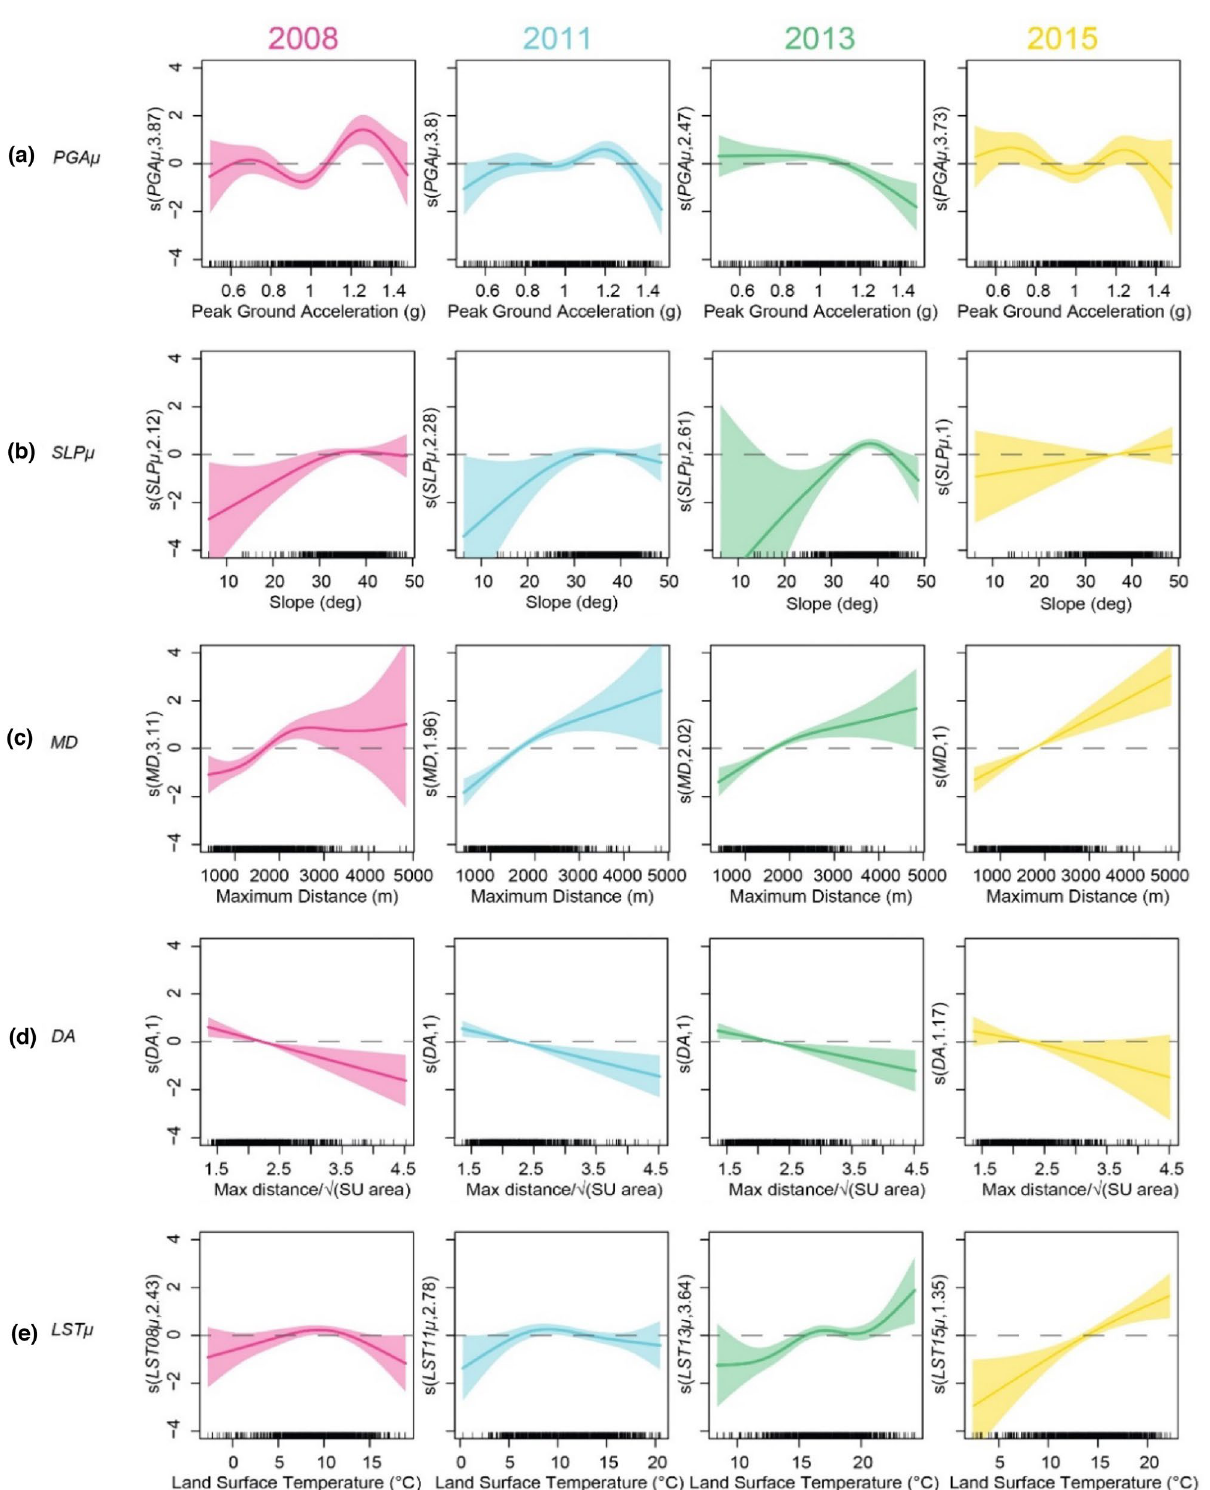
Figure 3. Variable effects of the model covariates over time. Effect of ( a ) mean peak ground acceleration, ( b ) mean slope, ( c ) maximum distance and ( d ) elongation of the SU, and ( e ) mean land surface temperature displayed as component smooth functions. The shaded areas are 95% confidence bands. The small vertical bars on the horizontal axes reflect the distribution of values across the SUs. The values in parentheses on the ordinates are the effective degrees of freedom, a proxy of the degree of non-linearity of the functions [software: R 3.6.3, https:// cloud.r- proje ct.